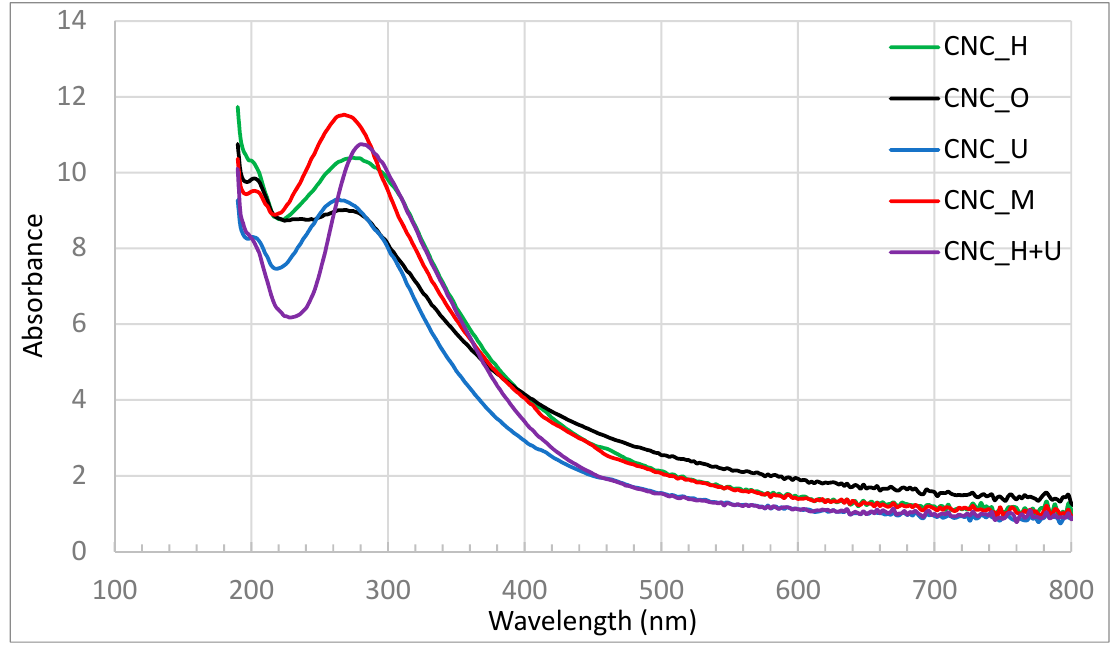
Figure 7. The UV-Vis spectra of CNC films.